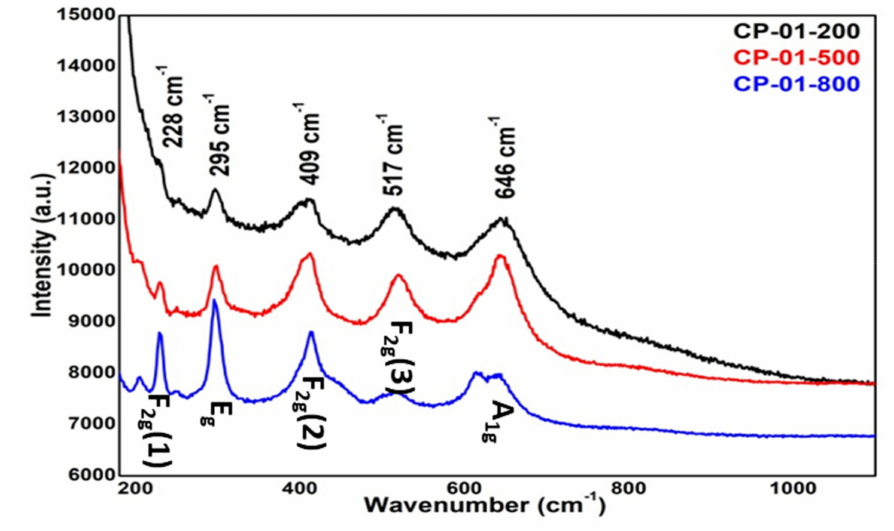
Figure 5. Raman spectra of NPs calcined at different temperatures.